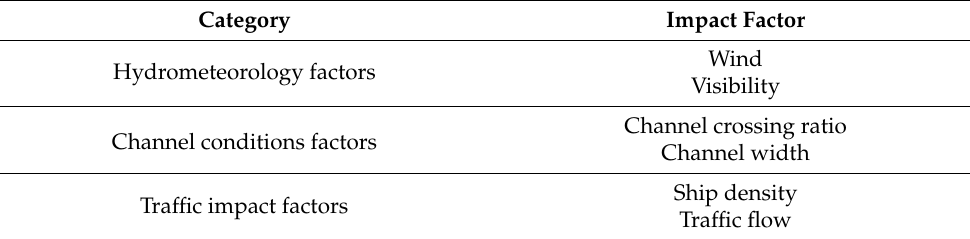
Table 2. Research Table 2. Research indicators.